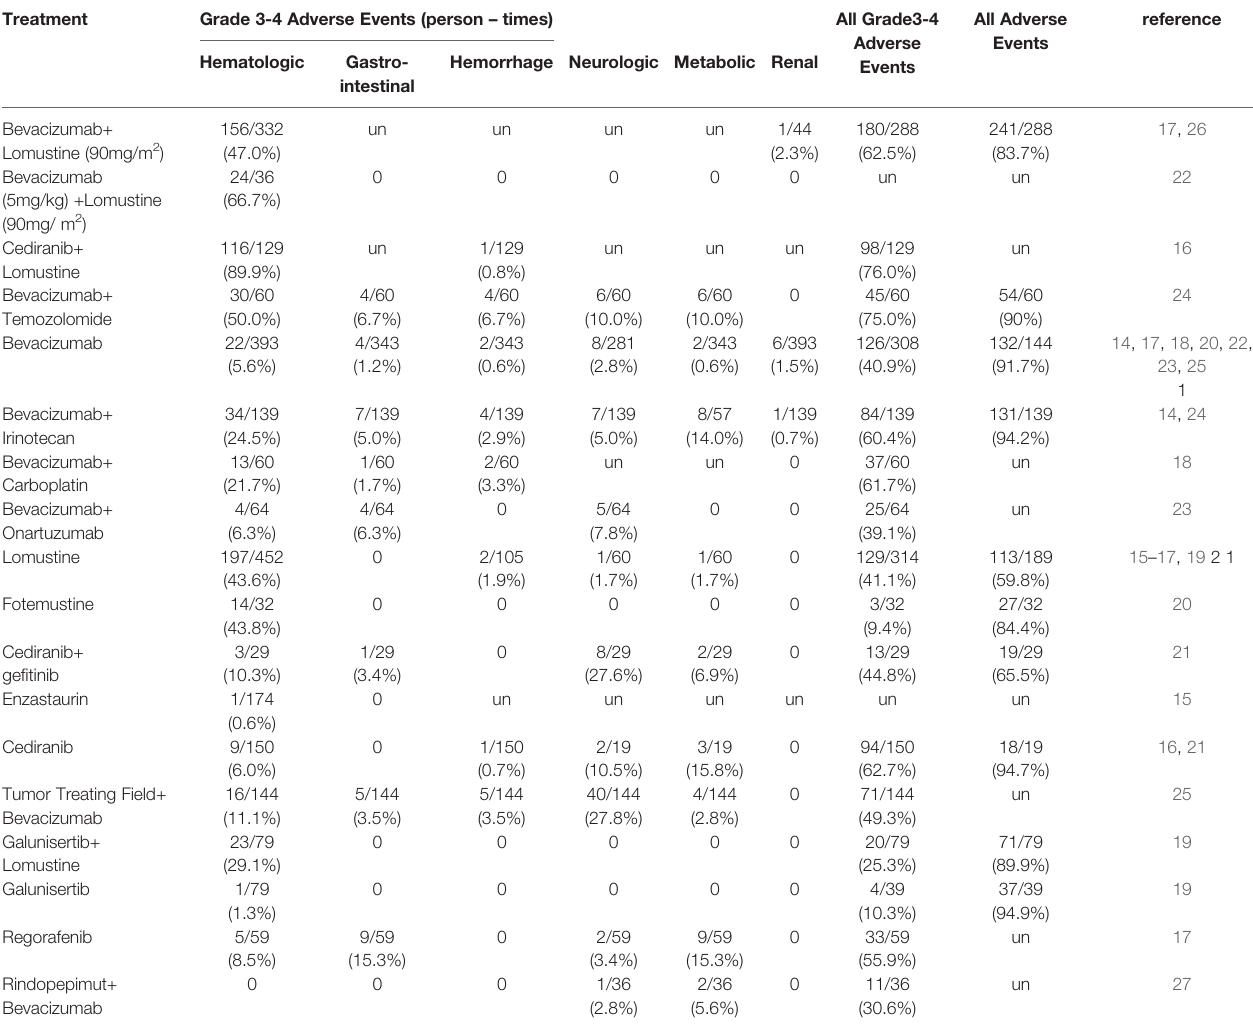
TABLE 2 | Percentage of Patients with Adverse Events According to Treatment. Treatment Grade 3-4 Adverse Events (person –